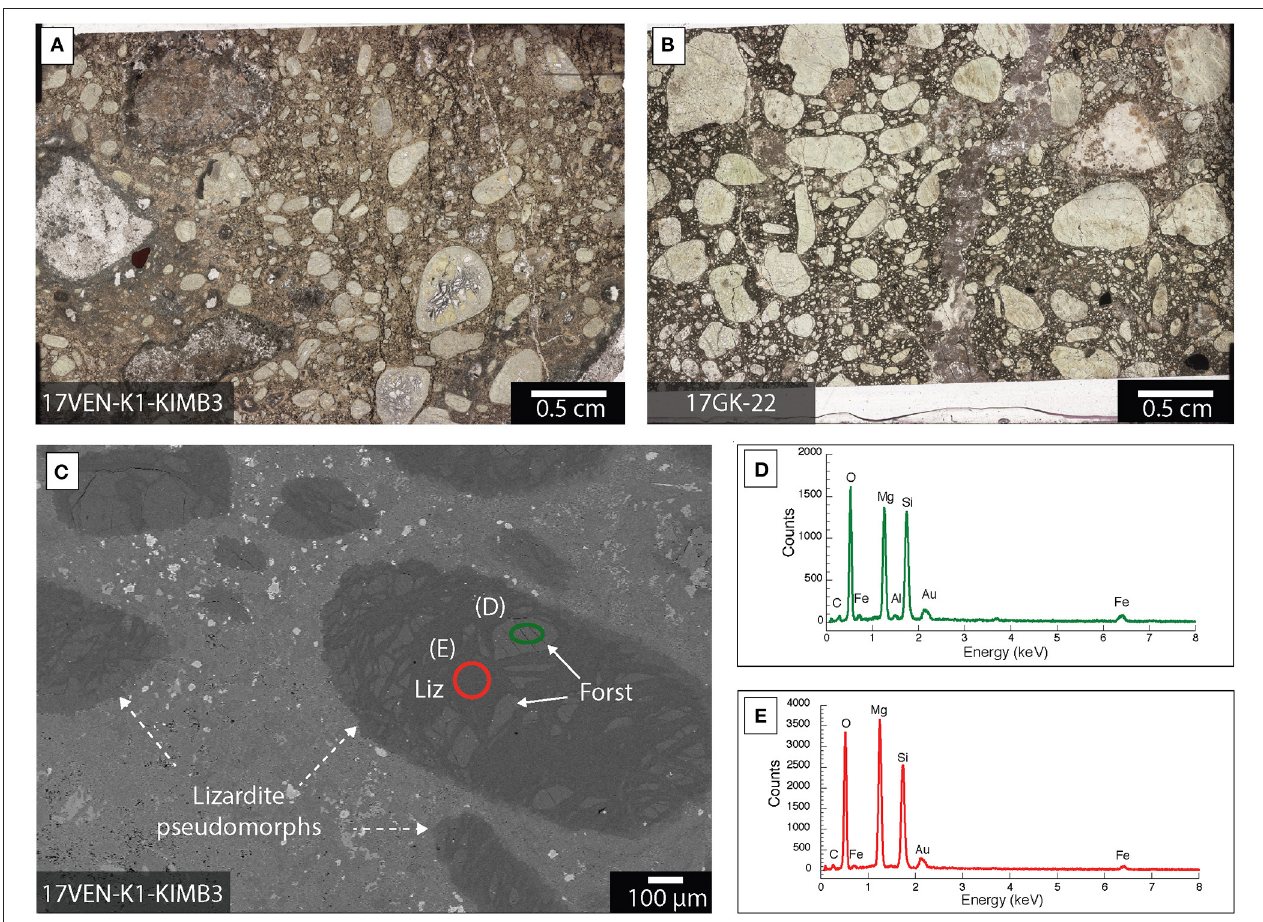
FIGURE 5 | Lizardite distribution within kimberlite ores from Venetia and Gahcho Kué. (A,B) Optical microscope images of the entire petrographic thin section for each of two different kimberlite ores; (C) Backscattered electron image of a petrographic thick section showing large lizardite (Liz) pseudomorphs grains (dashed arrows) containing regions with relict forsterite (Forst); (D,E) EDXS spectra corresponding to the areas circled in (C) . The sample was